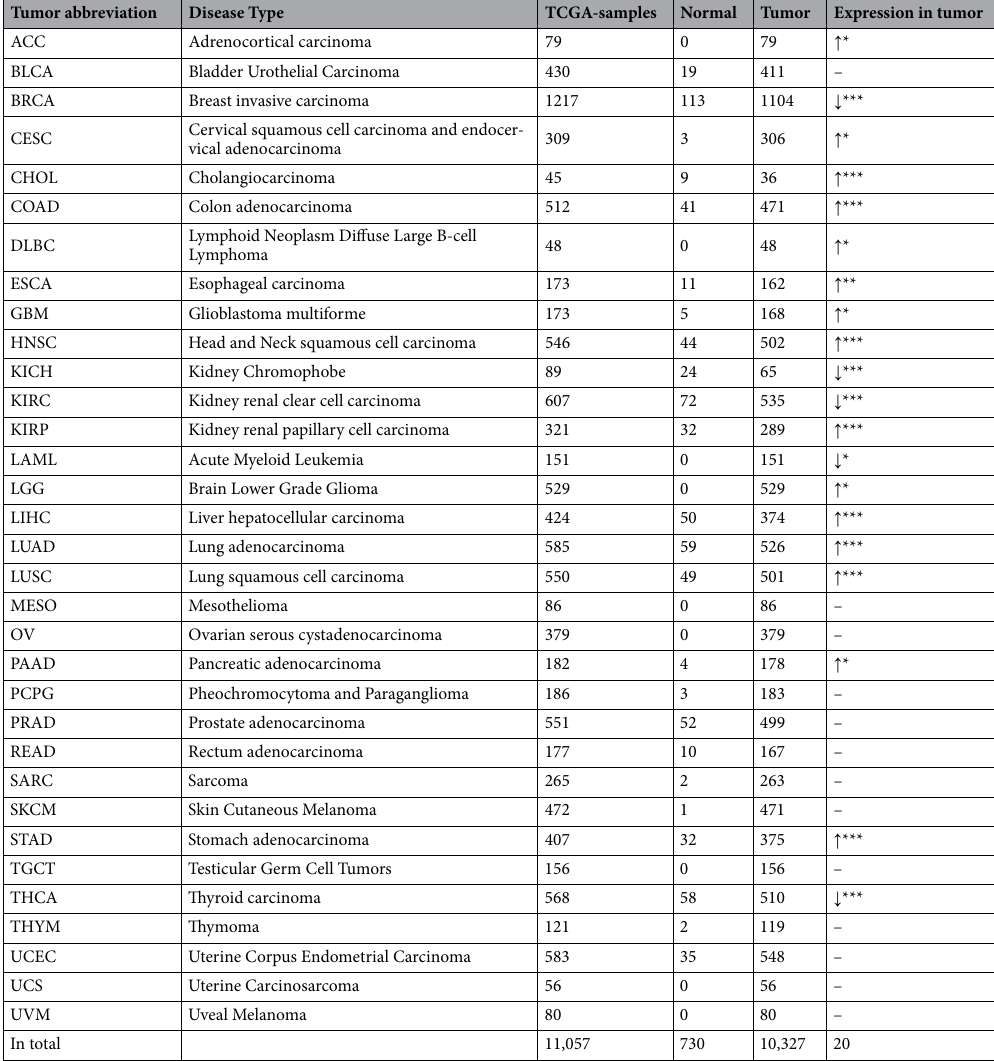
Table 1. Pan-cancer samples in TCGA database and tumor abbreviations. ↑ high expression; ↓ low